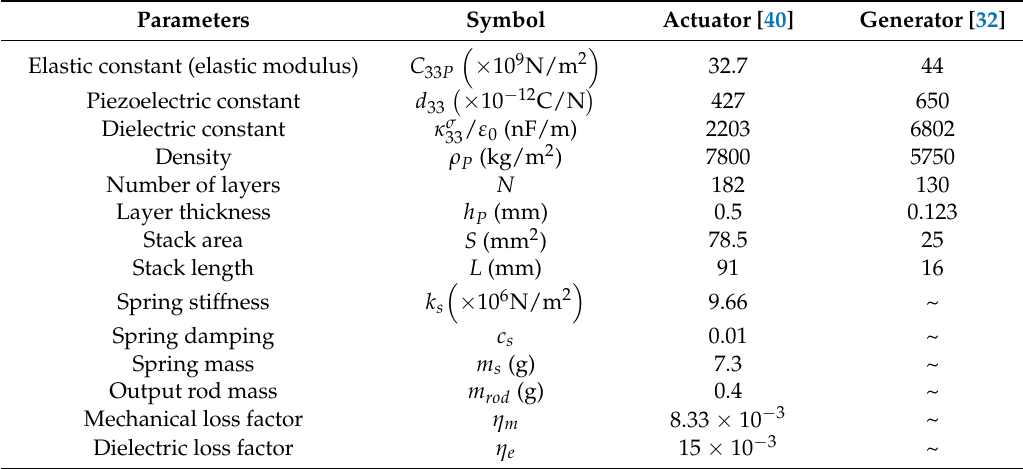
Table 1. Geometric and material parameters of the piezoelectric stack.